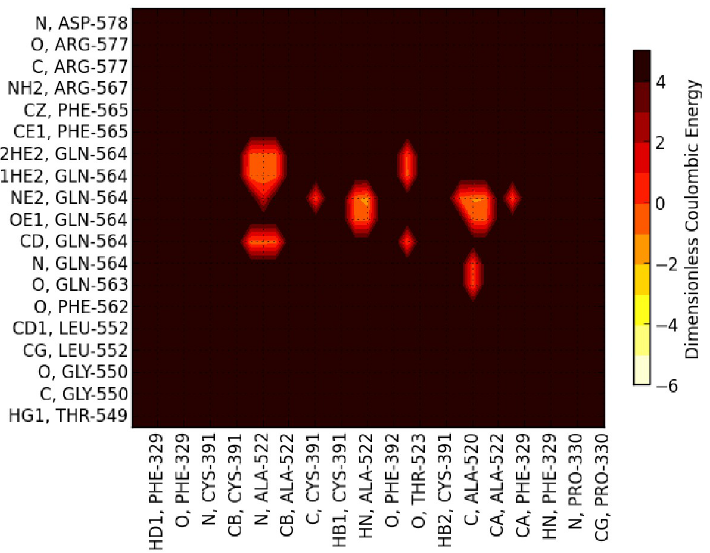
Fig 6. Zoomed dominant energy landscape for partial charge interactions between SD1/SD2 residues (vertical axis) and RBD residues of chain B (horizontal axis)showing the conspicuously unique residue interactions. Note that dominant van der Waals interactions involving PRO 521 backbone atoms are not shown here; see S7 and S8 Tables in S1 File.